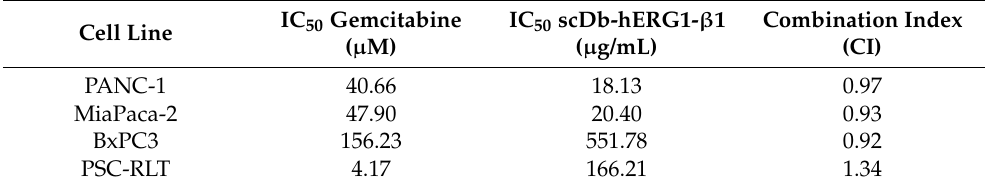
Table 2. IC 50 values of Gemcitabine and scDb-hERG1- β 1 on PANC-1, Mia Paca2, BxPC3 and PSC-RLT cells and respective combination index (CI) values. CI values were determined using Compusyn software. values agree with the expression levels of the hERG1/ β 1 integrin complex in the pancreatic cell lines studied. Starting from the IC 50 values experimentally determined, we used dif- ferent doses (IC 25 , IC 75 and IC 100 ) of either Gemcitabine, scDb-hERG1- β 1 or their combina- tions to measure the combination index (CI) as in [36] (Figure 4A). The CI values clearly indicate a synergistic e ff ect of the scDb-hERG1- β 1 and Gemcitabine combination but only in the PDAC cells which express the hERG1/ β 1 integrin complex (Table 2). The e ff ects of the combination of the IC 50 and IC 25 doses of Gemcitabine with the IC 50 of scDb-hERG1- β 1 on PANC-1 cells are shown in Figure 4B.